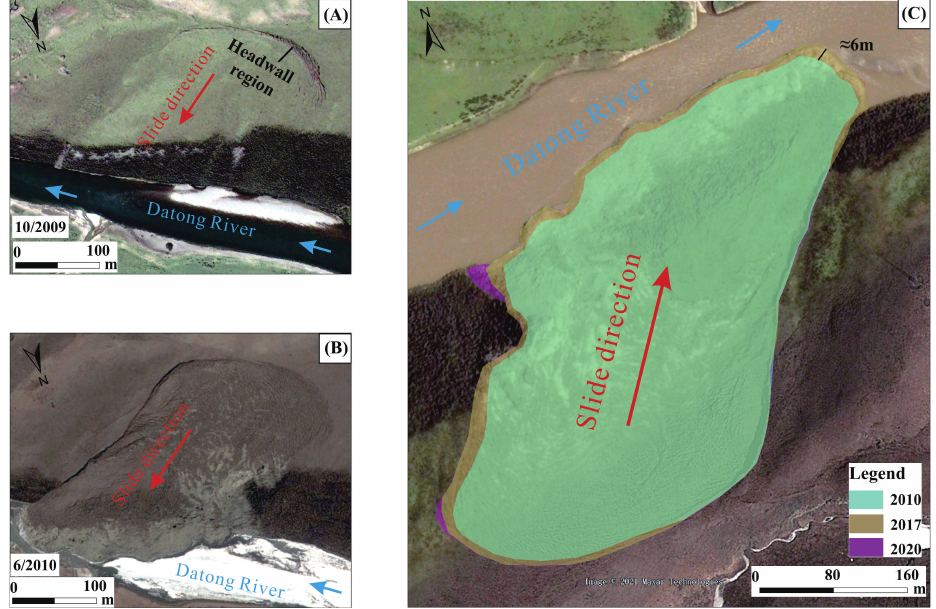
Figure 2. Temporal variations of landslide QLDT01: ( A , B ) Google satellite images of landslide boundary changes in 2009 and 2010 and ( C ) landslide evolution in 2010, 2017, and